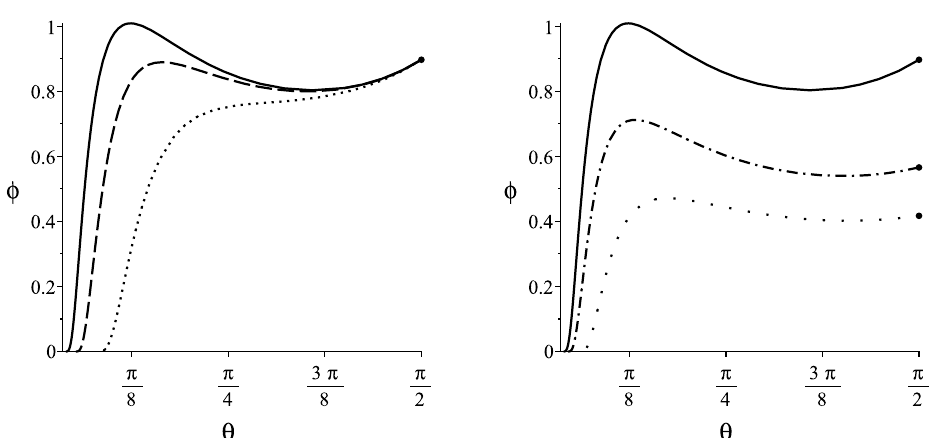
(cid:0) (cid:1) ’ ( t ) ; (cid:18) ( t ) for the same values of the constants as in (cid:12)gure 1. The dot